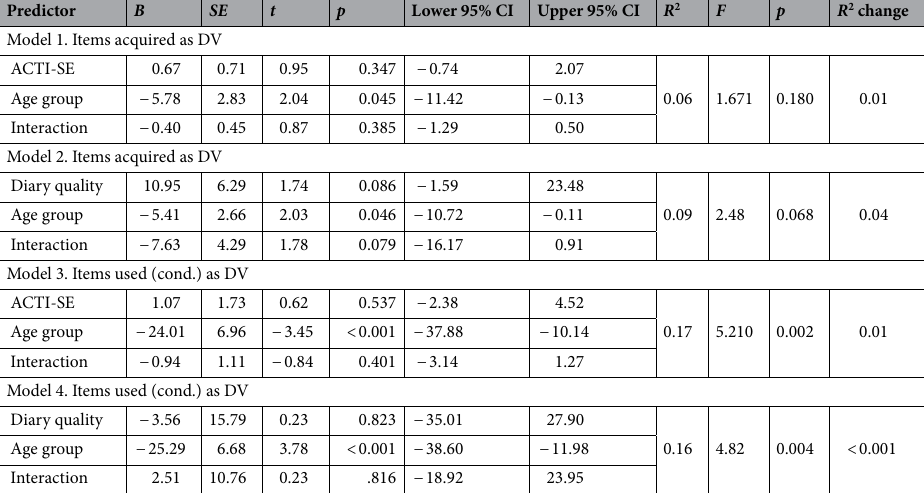
Predictor B SE t p Lower 95% CI Upper 95% CI R 2 F p Model 1. Items acquired as